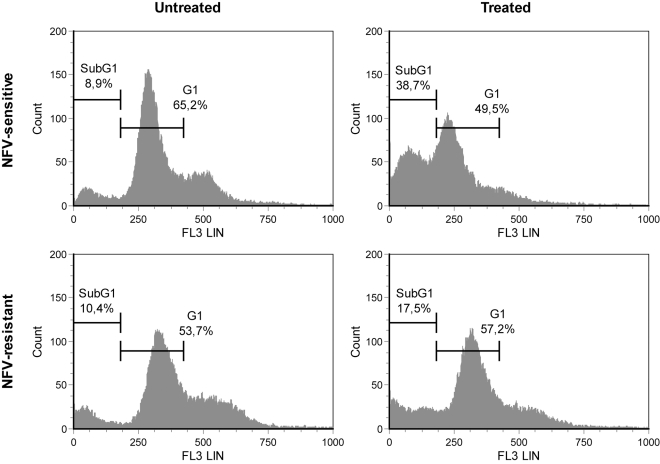
NFV induces an increase in the sub-G1 DNA-containing population.The DNA content degradation profiles of drug-sensitive and NFV-resistant axenic amastigotes (i.e. usually maintained under a constant drug pressure of 12.5 µM), which were either left untreated or treated with NFV (10 µM), were assessed by flow cytometry after cell permeabilisation and PI staining. DNA fragmentation was quantified by measuring the cell population in the sub-G1 DNA region indicated by M1 and G1 DNA peak indicated by M2. The data shown are representative of three independent experiments.